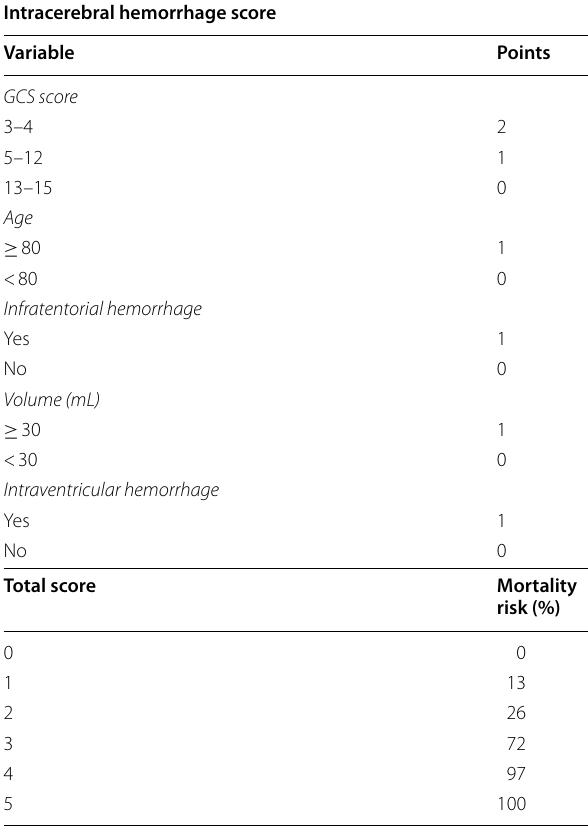
Table 2 The intracerebral hemorrhage score and the mortality rates associated with a total score of